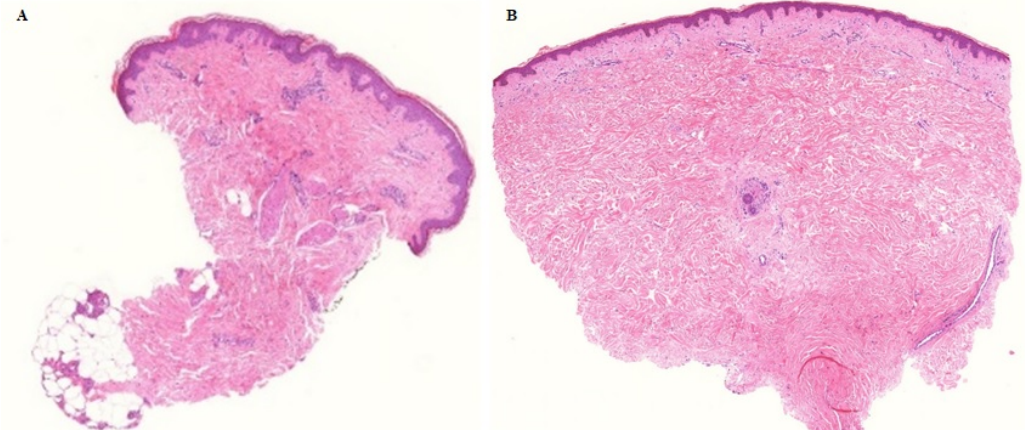
Figure 4. Histologically confirmed complete remission 6 months after Ca-EP. Tumour cells were not identified 6 months after Ca-EP neither in malignant melanoma ( A ) nor in breast cancer metastases ( B ). A: patient no 3, Ca-EP treated clinically CR melanoma malignum cutaneous metastasis. B: patient no 2, Ca-EP treated clinically CR breast cancer cutaneous metastasis. Histological photos: digital scanning with low magnification.